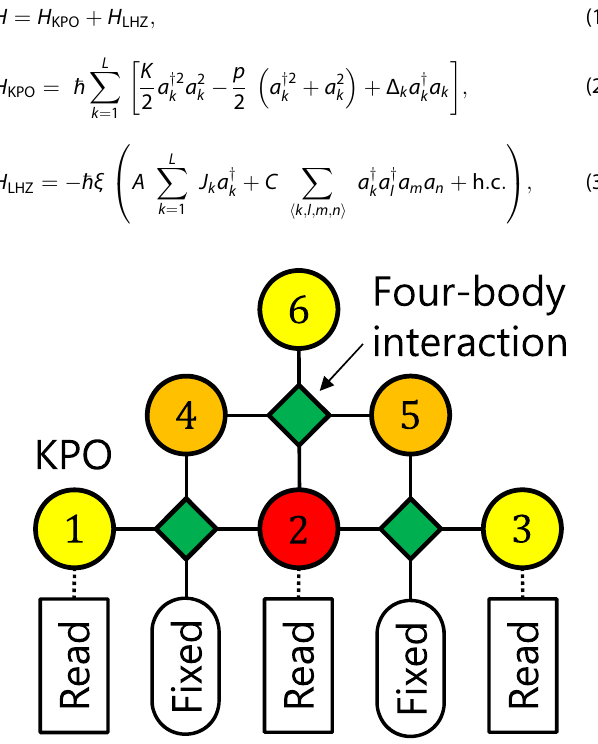
Fig. 1 A network of Kerr-nonlinear parametric oscillators in the Lechner – Hauke – Zoller scheme for the four-spin Ising problem. Here N = 4 and L = 6. KPOs 1 – 6 correspond to LHZ spins ~ s k ¼ ±1 , while the ancillary LHZ spins (Fixed) fi xed to 1 are implemented by classical driving. A four-body constraint is imposed on four LHZ spins connected by a square (in green), which constitute a plaquette. The number of the four-body interactions (squares in green) connected to the k th KPO, z k , are z 1 = z 3 = z 6 = 1, z 4 = z 5 = 2, and z 2 = 3 (see the main